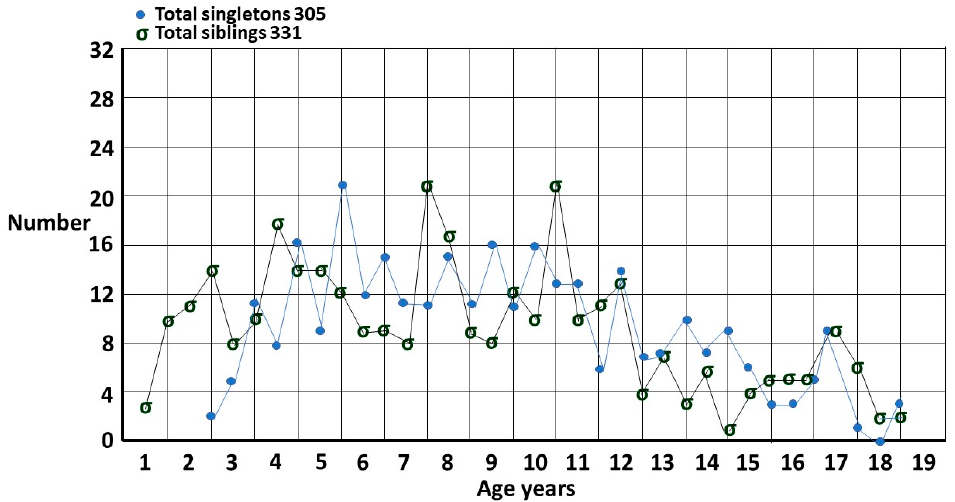
Figure 3. Singletons and siblings for each 6 months of age.